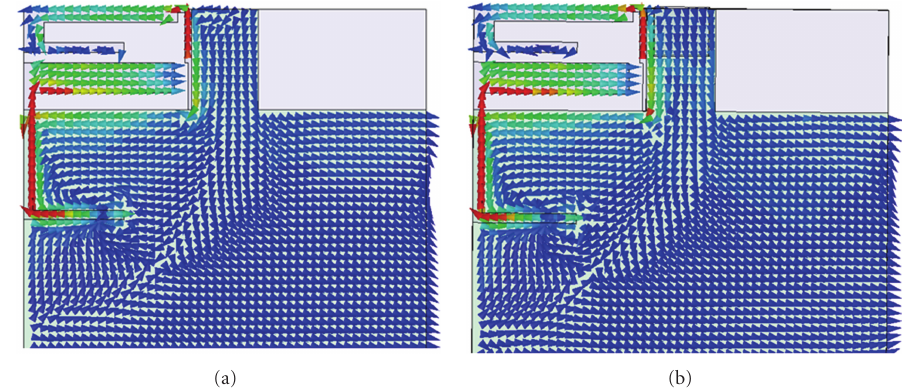
Figure 8: Simulated current distribution with (a) and without (b) the presence of USB.